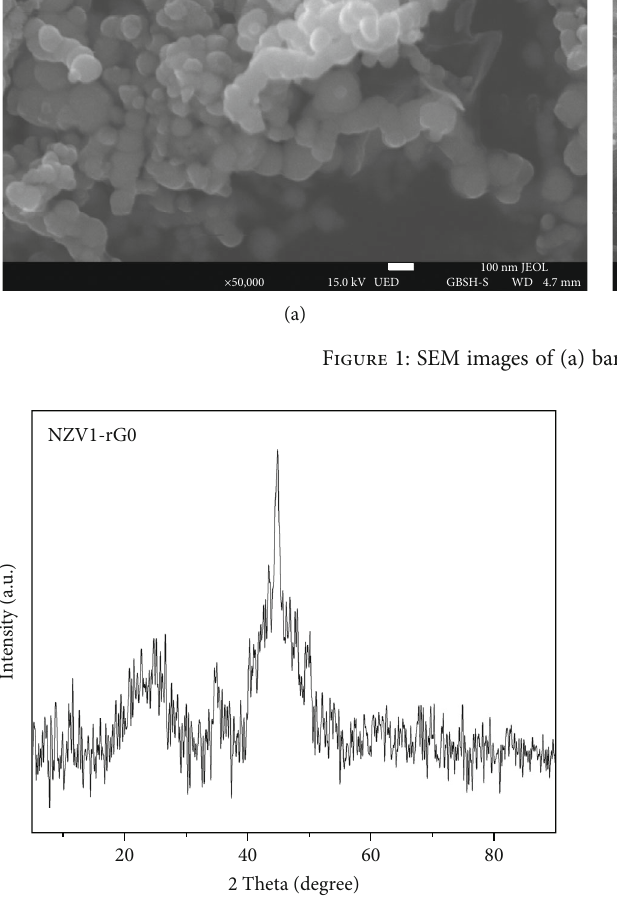
Figure 3: FTIR spectra of the GO